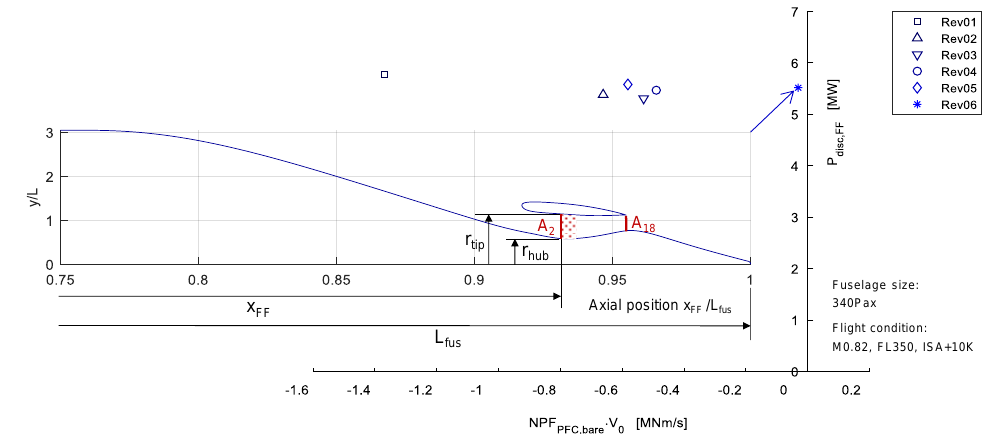
Figure 6. Evolution of the aerodynamic performance of the bare PFC fuselage (adapted from [50]). To align the optimized design with the target values of the pre-design studies [43], the Rev06 optimization was modified to meet the following additional equality con- straints: FPR equal to 1.40